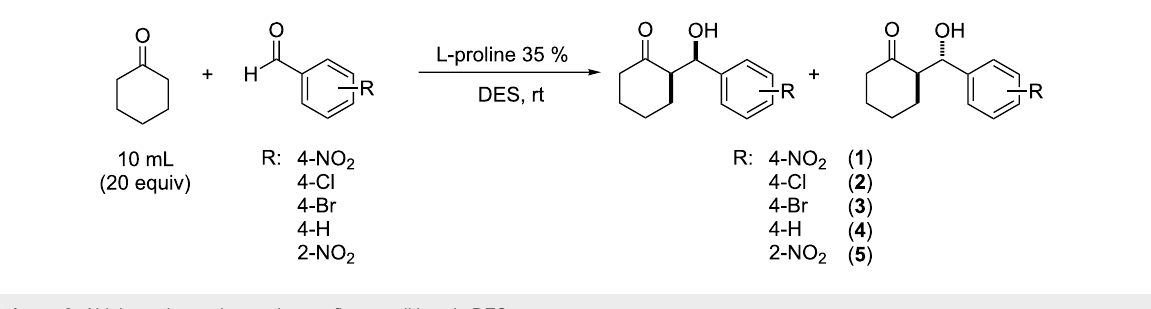
Scheme 2: Aldol reaction under continuous flow conditions in